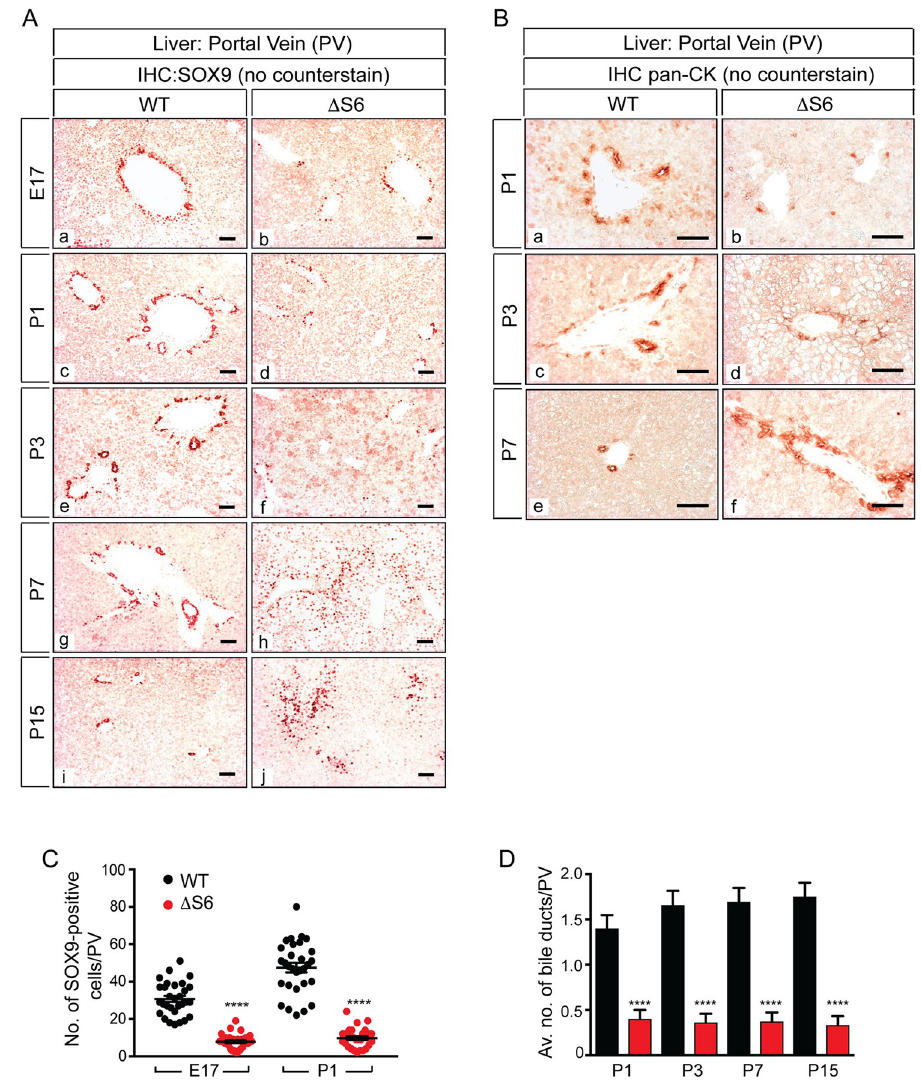
Fig 2. Hepatic Rps6 -deficiency inhibits bile duct development. (A) Photomicrographs of SOX9 IHC of WT (a, c, e, g, i) and Δ S6 (b, d, f, h, j) livers from E17 to P15 (Original magnifications, all x 125; 50 μ scale bars) (AEC chromogen (red/orange), no counterstain). Note the gradual disappearance of SOX9-positive cells from the ductal plate in Δ S6 livers between E17-P3 and the abnormal position and expansion of SOX9-positive cells throughout the parenchyma from P7 onwards. (B) Photomicrographs of pan-CK IHC of WT (a, c, e) and Δ S6 (b, d, f) livers from P1 to P7 showing that the number of pan-CK-positive biliary cells in Δ S6 livers is also reduced at P1 and P3 (b and d) while their expansion at P7 (f) mirrors the increase in the number of SOX9-positive cells (A (h)) signifying emergence of a nascent ductular reaction. (Original magnifications, all x 250; 50 μ scale bars) (AEC chromagen (red/orange), no counterstain). (C) Graph depicting quantitative analysis of the number of SOX9-positive cells around portal veins (PVs) in WT and Δ S6 livers at E17 and P1. Δ S6 livers have 20–25% of the normal number of SOX9-positive cells (mean values 7.8 vs 30.7 at E17; P < .0001 and 9.8 vs 47.5 at P1; P < .0001); 2-tailed unpaired Student’s t -test. (D) Graph showing average number of bile ducts per portal vein (PV) (bds/PV) in WT and Δ S6 livers at P1, P3, P7 and P15. While WT livers have an average of 1–2 fully formed bds/PV, Δ S6 livers have an average of < 0.5. Data are mean ± SEM; ���� P < .0001; 2-tailed unpaired Student’s t -test.